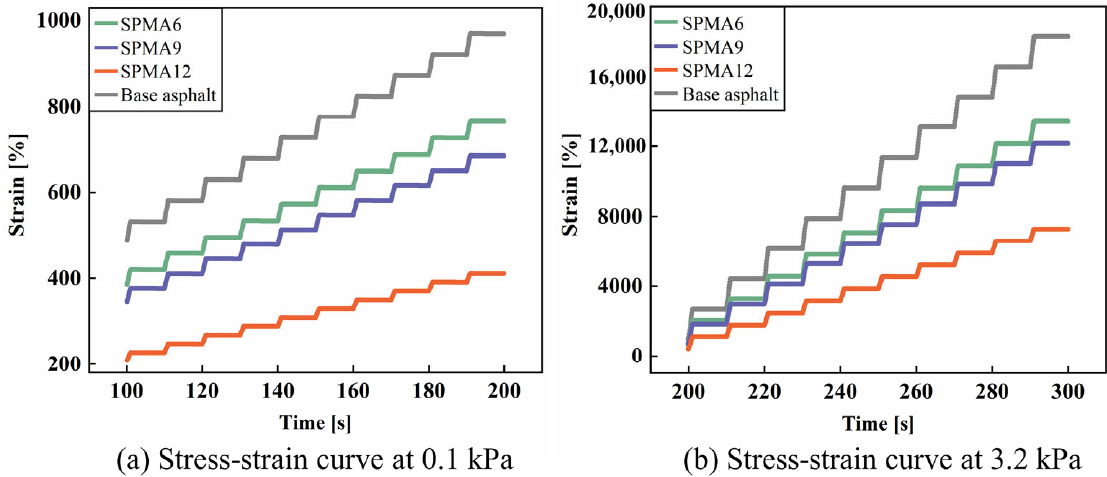
Figure 12. MSCR test results of asphalt binders.